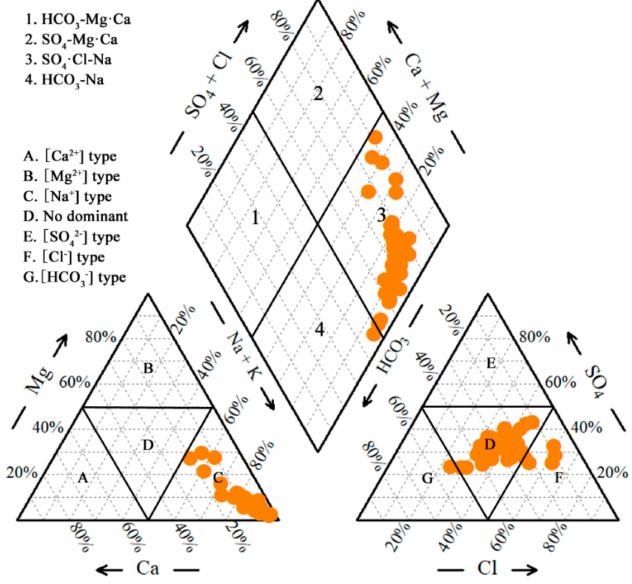
Figure 4. Piper trilinear diagram for groundwater